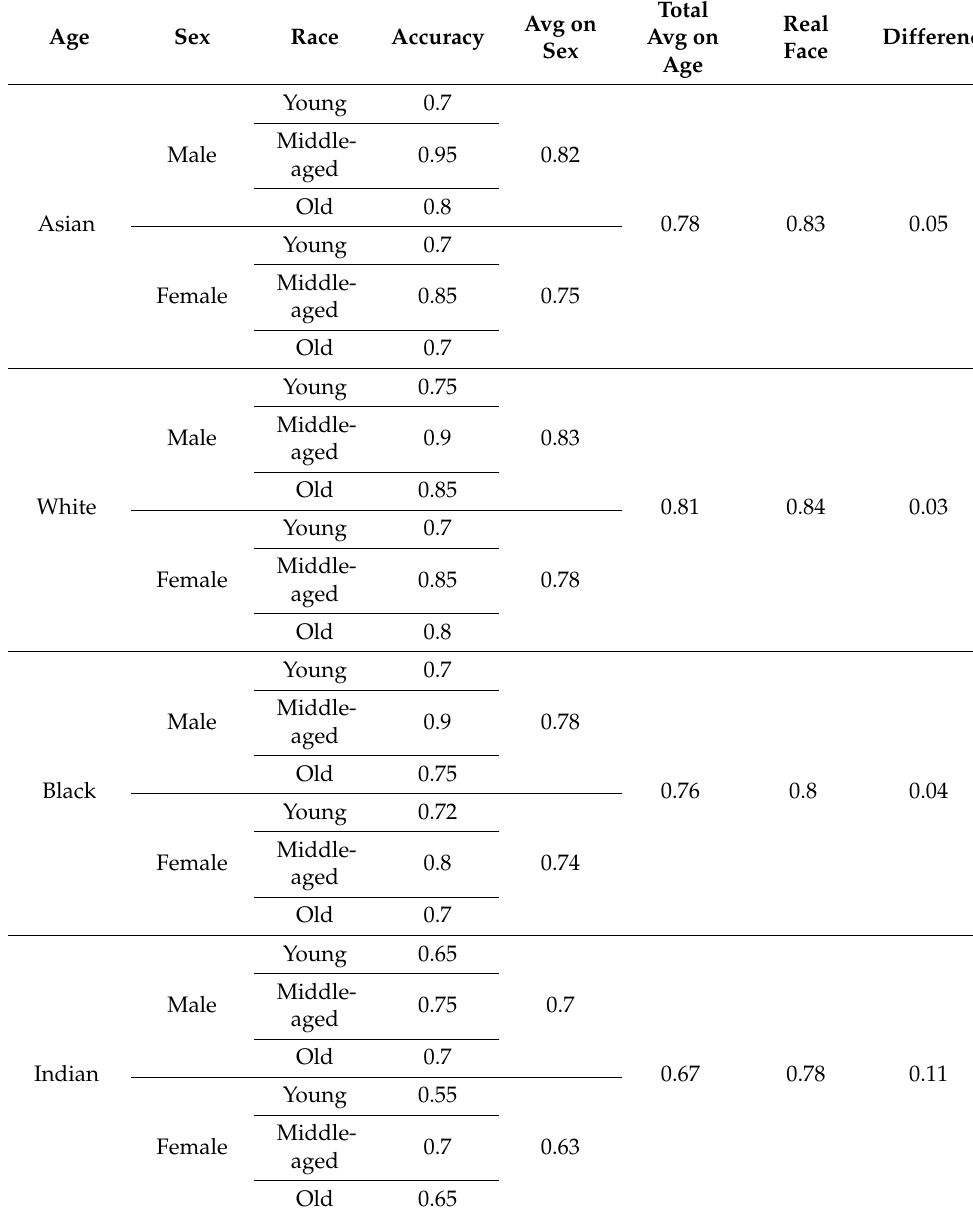
Table 4. Accuracy of a facial recognition model on racial recognition for generated and real